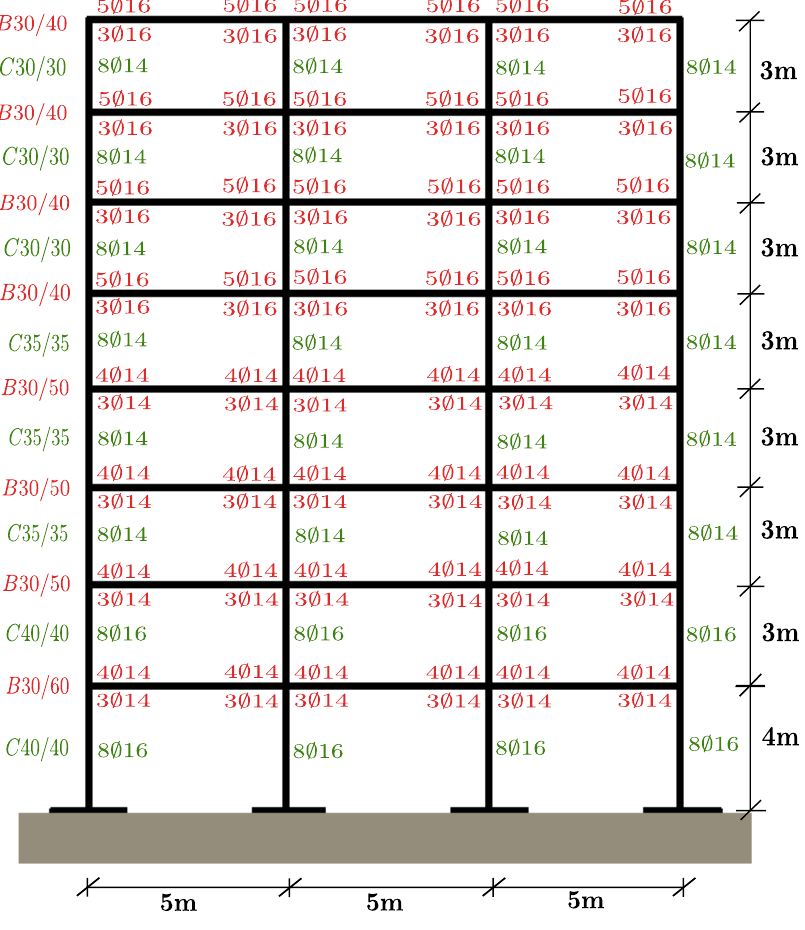
Figure 2. The examined Reinforced Concrete